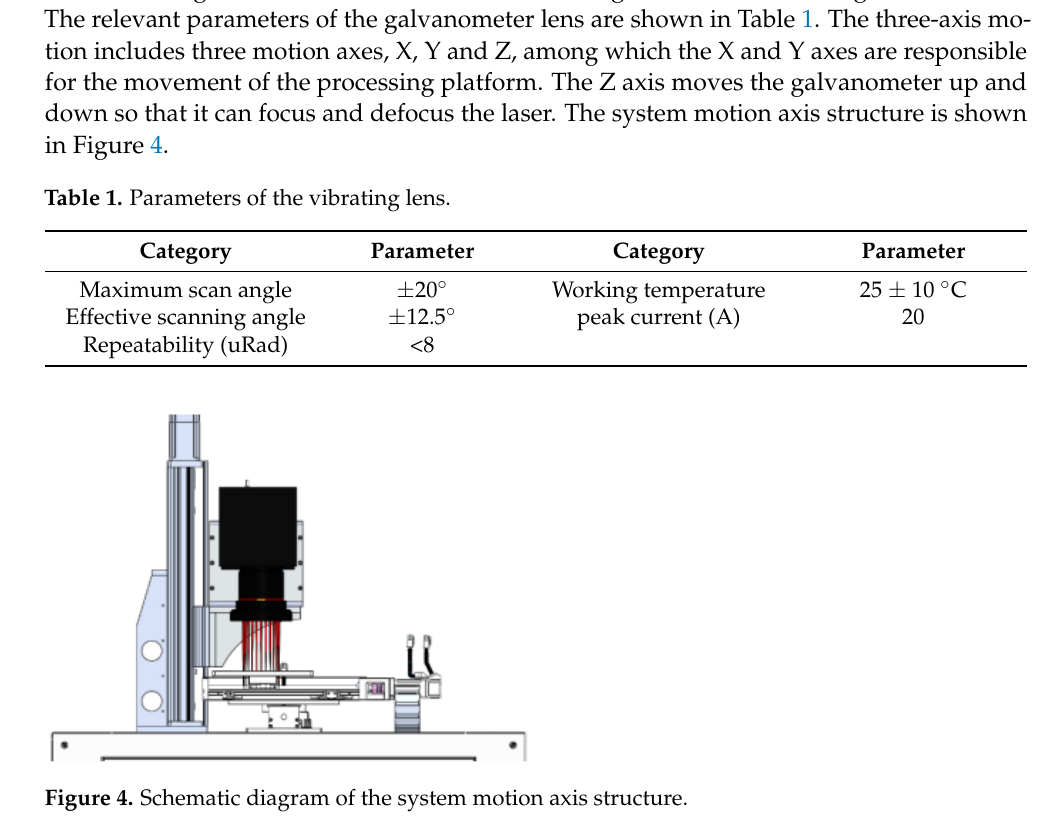
Figure 3. Overall frame diagram of the system.